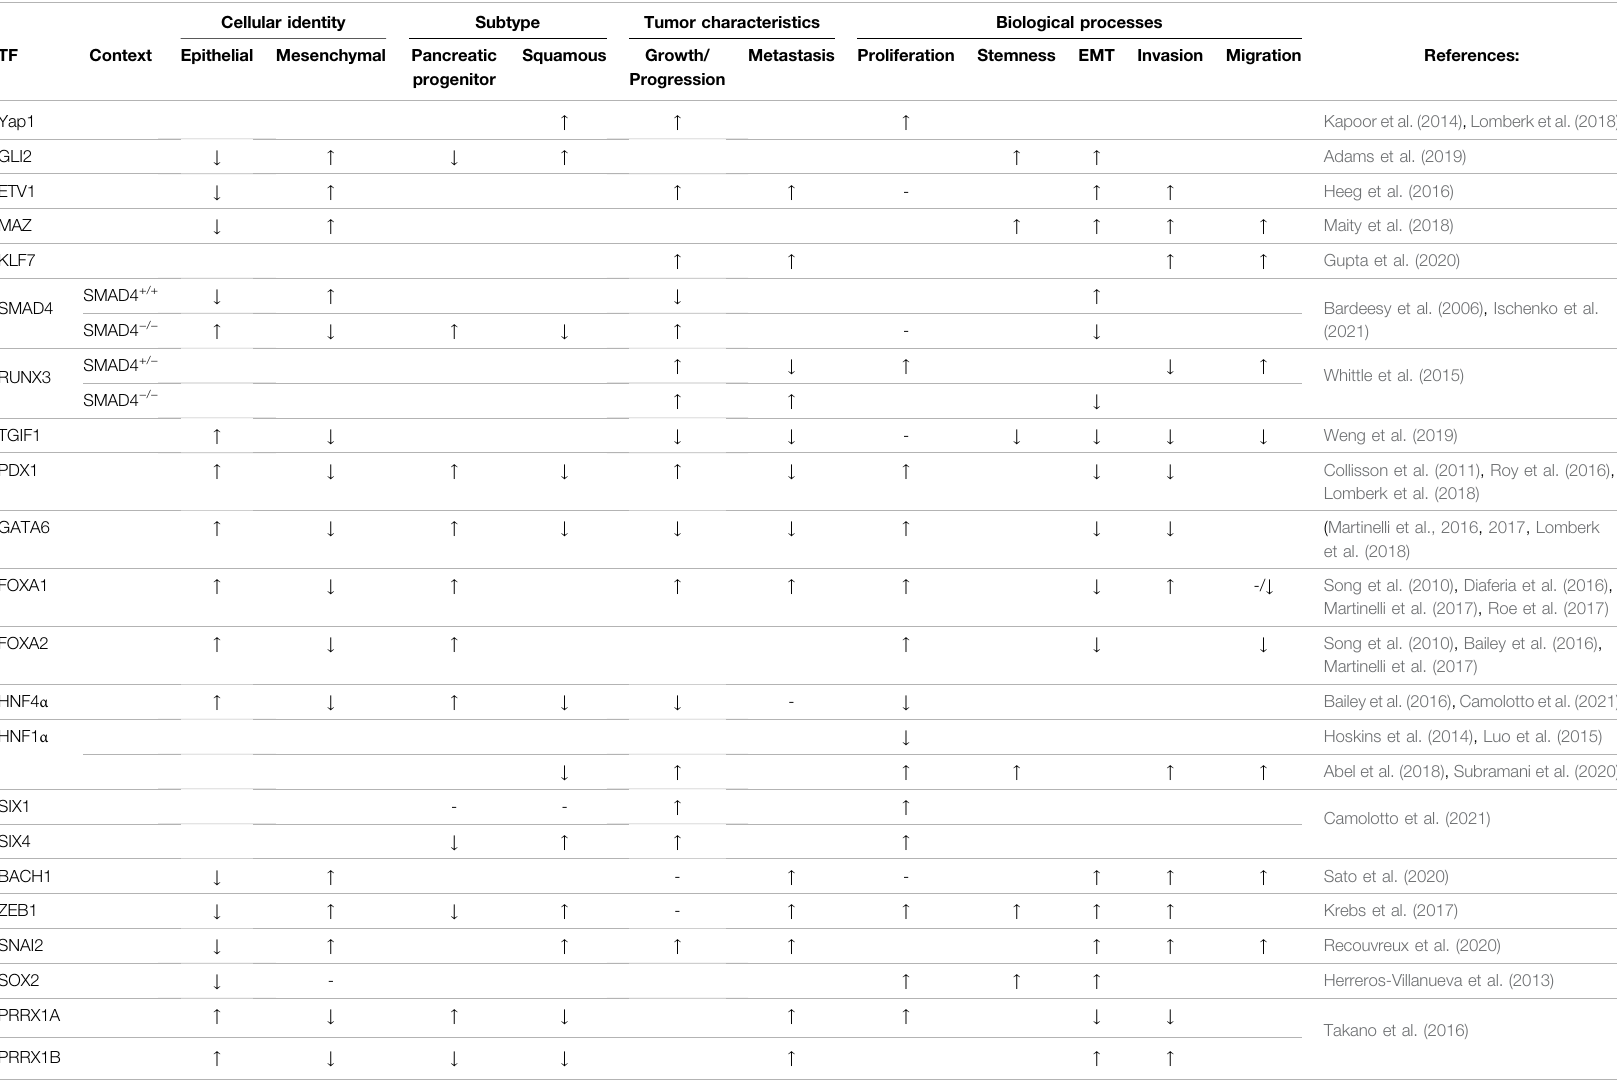
TABLE 1 | Overview of the individual TFs and their effects upon elevation in primary PDAC tumors. In fl uence on cellular identity, subtype, tumor characteristics and biological processes are highlighted. An upward pointing arrow( ↑ ) indicates promoting effects,adownward pointingarrow ( ↓ )inhibitory effects,aminus symbol ( − )norpromoting norinhibitoryeffects.Blank cellsre fl ect thattheprocess wasnotanalyzed ornoconclusioncould be drawn from the indicated